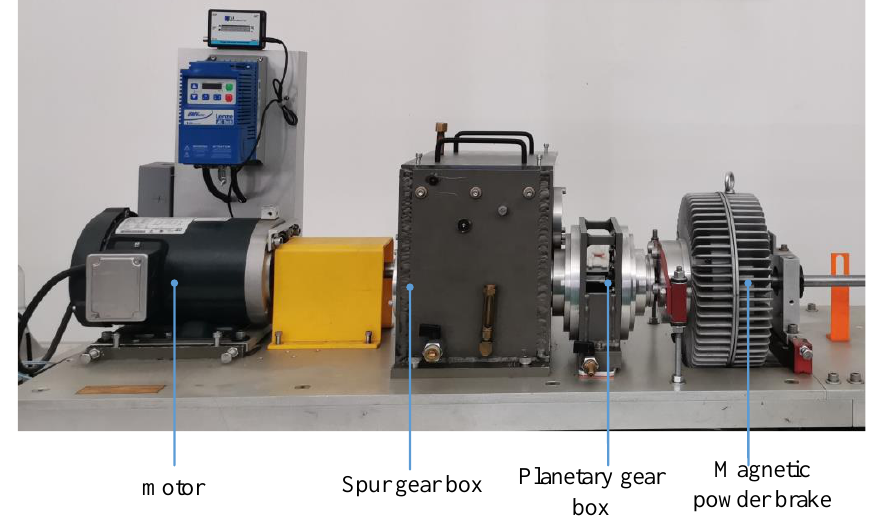
Figure 2. Structure of the wind turbine transmission system.